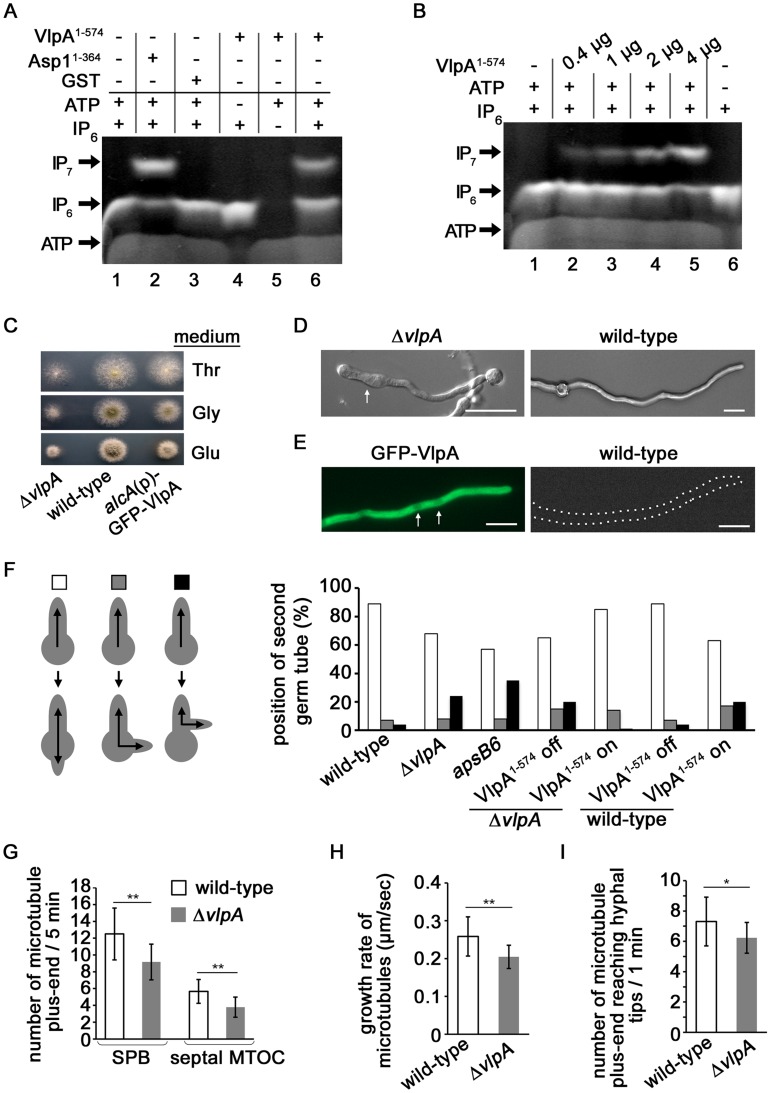
Function of Vip1-like protein A. nidulans VlpA.(A) VlpA has kinase activity. 2 µg GST-VlpA1-574 or GST-Asp11-364 (kinase domain only) were used in an enzymatic reaction as described [54]. −, component not present in assay; +, component present in assay. (B) Correlation between GST-VlpA1-574 protein amount/assay and the amount of IP7 generated. (C) Colonies of the vlpA-deletion strain ΔvlpA (left), wild-type (middle) and a strain in which GFP-VlpA was expressed under the control of alcA promoter (right). The strains were grown on minimal medium agar with threonine (upper), glycerol (middle) or glucose (bottom) for 2 days at 37°C. (D) The ΔvlpA strain (SCoS94, left) and wild-type strain (right) were grown in minimal medium with glucose overnight at 28°C. Some hyphae showed swelling in the ΔvlpA strain (arrow). Bars, 10 µm. (E) Growth conditions of the GFP-VlpA strain (Scos176) as in (D). GFP-VlpA expressed under native promoter localized predominantly in the cytoplasm with weak nuclear staining (arrows). The wild-type strain photographed under the same condition is shown on the right. Bars, 10 µm. (F) Left panel: position of the second germtube or branch: second germtube opposite first germtube (white), random position (grey) or second hypha branching out of the first hypha (black). Right panel: quantification of the number of germlings with a second germtube in the indicated strains. Spores were grown in minimal medium with glucose overnight. To induce expression of VlpA1-574, minimal medium with glycerol was used. N germlings/strain = 100. (G) Number of MT plus-ends appearing from the SPB or septal MTOC during 5 minutes in the wild-type (SSK92, white) and the vlpA-deletion strain (SDO2, grey). At SPB, wild-type: n = 20, ΔvlpA: n = 12, **p<0.01 as determined using t-test. At MTOC, wild-type: n = 10, ΔvlpA: n = 9, **p<0.01 as determined using t-test. (H) Growth rate of MT in the wild-type (SSK92) and the ΔvlpA strain (SDO2, grey). N = 10 cells for each of the strains, **p<0.01 as determined using t-test. (I) Number of MT plus-ends reaching hyphal tips during 1 minute in the wild-type (SSK92) and ΔvlpA strain (SDO2). N = 13 cells for each of the strains, *p<0.05 as determined using t-test.